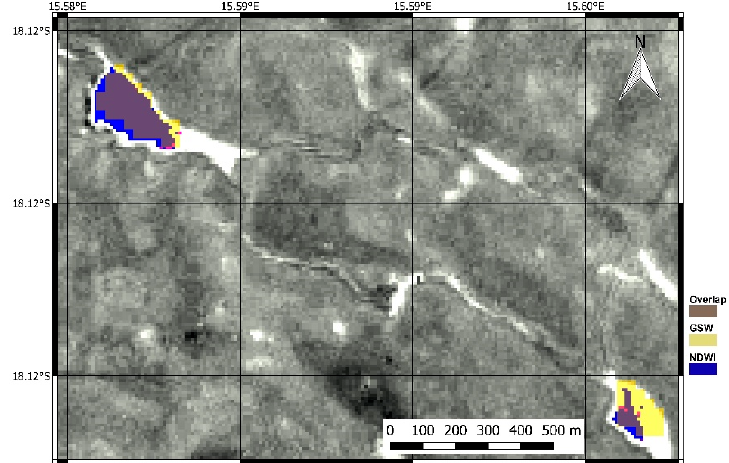
Figure 4. Comparison B: Oshana GSW for September 2015 (orange) with Sentinel-2A L1C NDWI (blue > 0.5) from 18 September 2015.